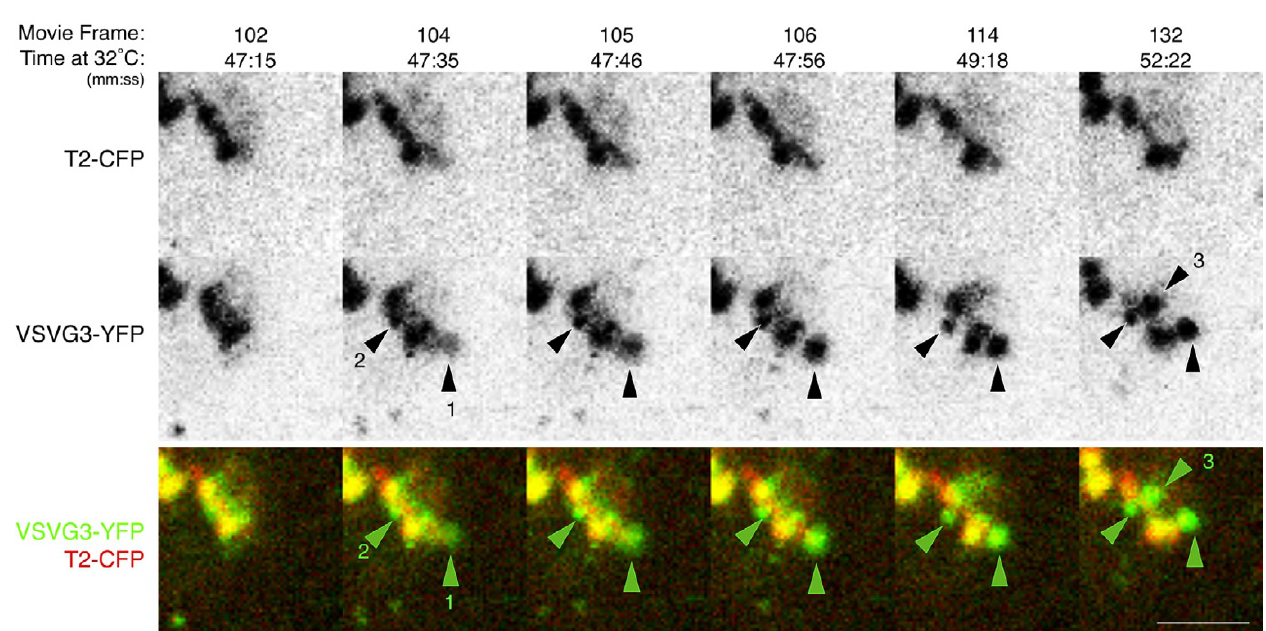
Figure 3 Cargo in Golgi elements forms large domains rapidly by lateral segregation Transiently expressed VSVG3-YFP cargo was accumulated in the ER and pulsed into the secretory pathway of PtK 2 cells as in Figure 1B. Time at 32 ° C and the frame number from the movie in Additional Fileset 3 are indicated. Cargo and Golgi resident initially coincide in Golgi ele- ments, with small domains of cargo visible (47:15). Within 11 s, a large region containing primarily cargo pulls off (47:35, arrow- head 1) and by 49:18 consolidates into a more compact cargo domain. This domain retains a core of membrane containing T2- CFP. A smaller cargo domain pulls off beginning at 47:16 (arrowhead 2), and an additional large domain coalesces rapidly between 49:18 and 52:22 (arrowhead 3). Cargo domains and Golgi elements exhibit complementary dynamics (Results), indi- cating they are regions of a contiguous structure. Bar: 5 µ